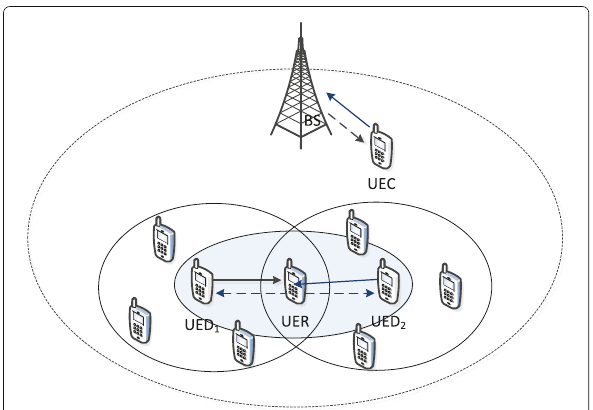
Fig. 1 A D2D communication aided by two-way DF relaying underlaying cellular network